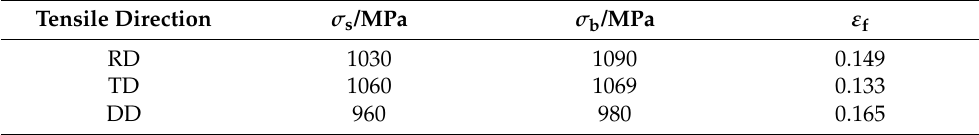
Figure 3. ( a ) Engineering stress-strain curves and ( b ) corresponding work-hardening curves of the Ti-6Al-4V samples tensioned in RD, DD, and TD orientations. Table 2. Mechanical properties of Ti-6Al-4V obtained in different tensile directions.